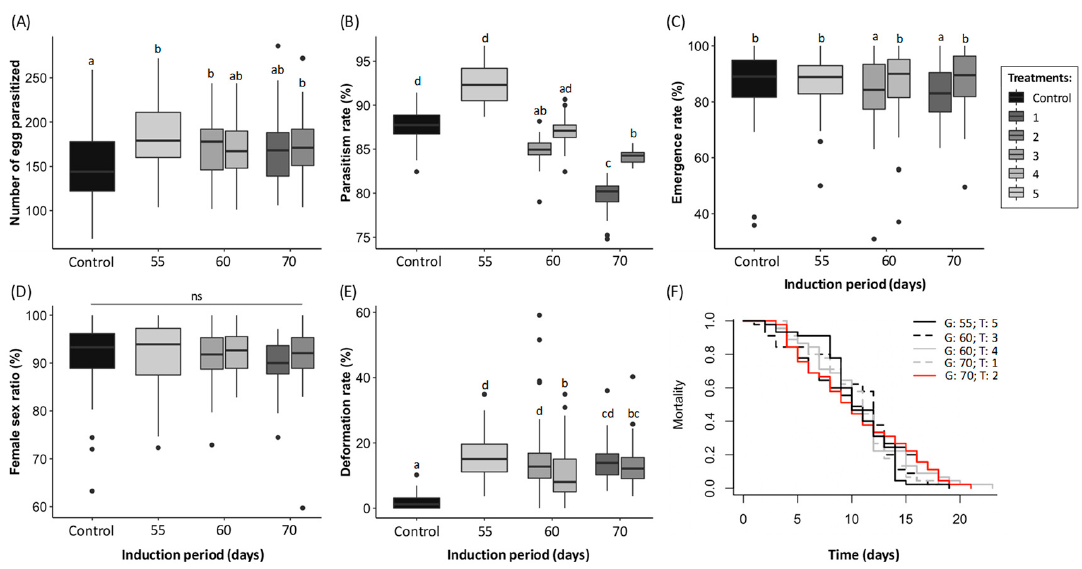
Figure 2. ( A ) Number of egg parasitized (turn black), ( B ) parasitism rate (proportion of egg with a hole), ( C ) emergence rate (proportion of adult emerged), ( D ) female sex ratio, ( E ) deformation rate of adult , and ( F ) longevity (days) of T. dendrolimi depending on the group (diapause induction at 3 °C for 55, 60 or 70 days) and the treatment (1): 25 °C until emergence; 2:10 °C for 2 days followed by 25 °C until emergence; 3:10 °C for 5 days followed by 25 °C until emergence; 4:10 °C for 2 days followed by 20:15 °C for 16:8 h per day for 2 days, then 25 °C until emergence; 5:10 °C for 2 days